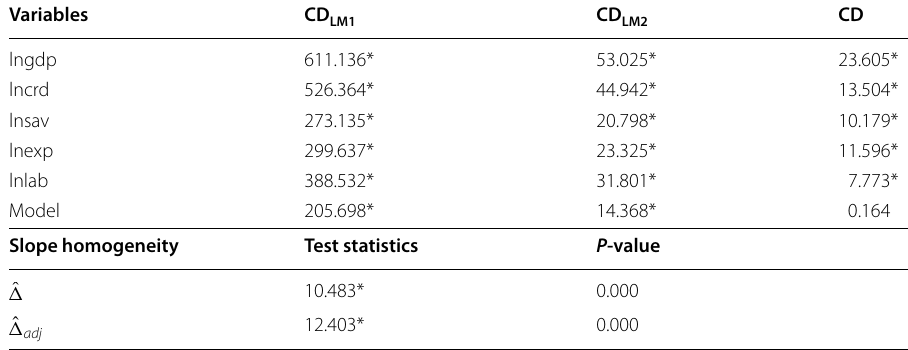
*Indicates the rejection of the null hypothesis at a 1% significance level